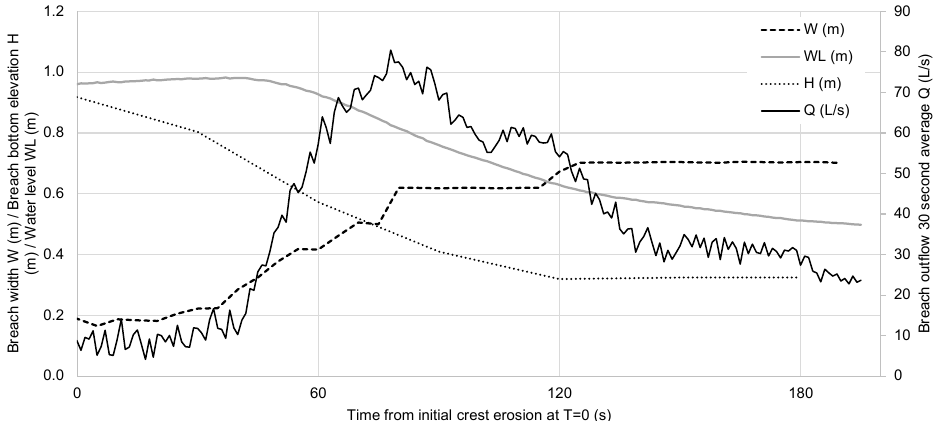
Figure 15. Breach width (W) and breach bottom elevation (H) for model H1 (no core) plotted against breach out fl ow (Q) and upstream water level (WL).